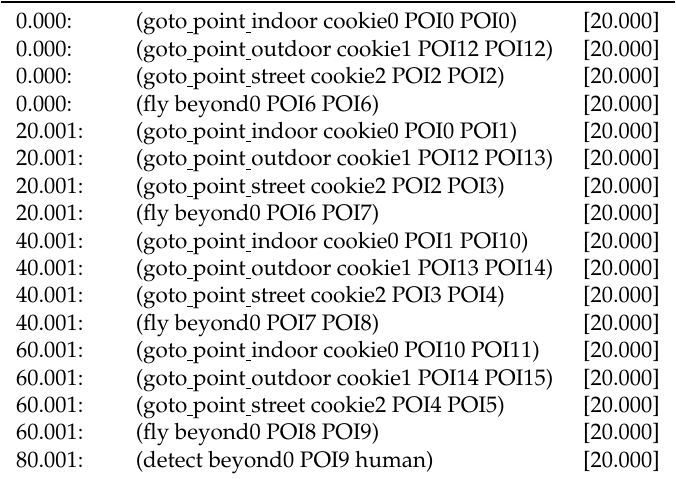
Table 1. Generated plan for Part 1 of the scenario.